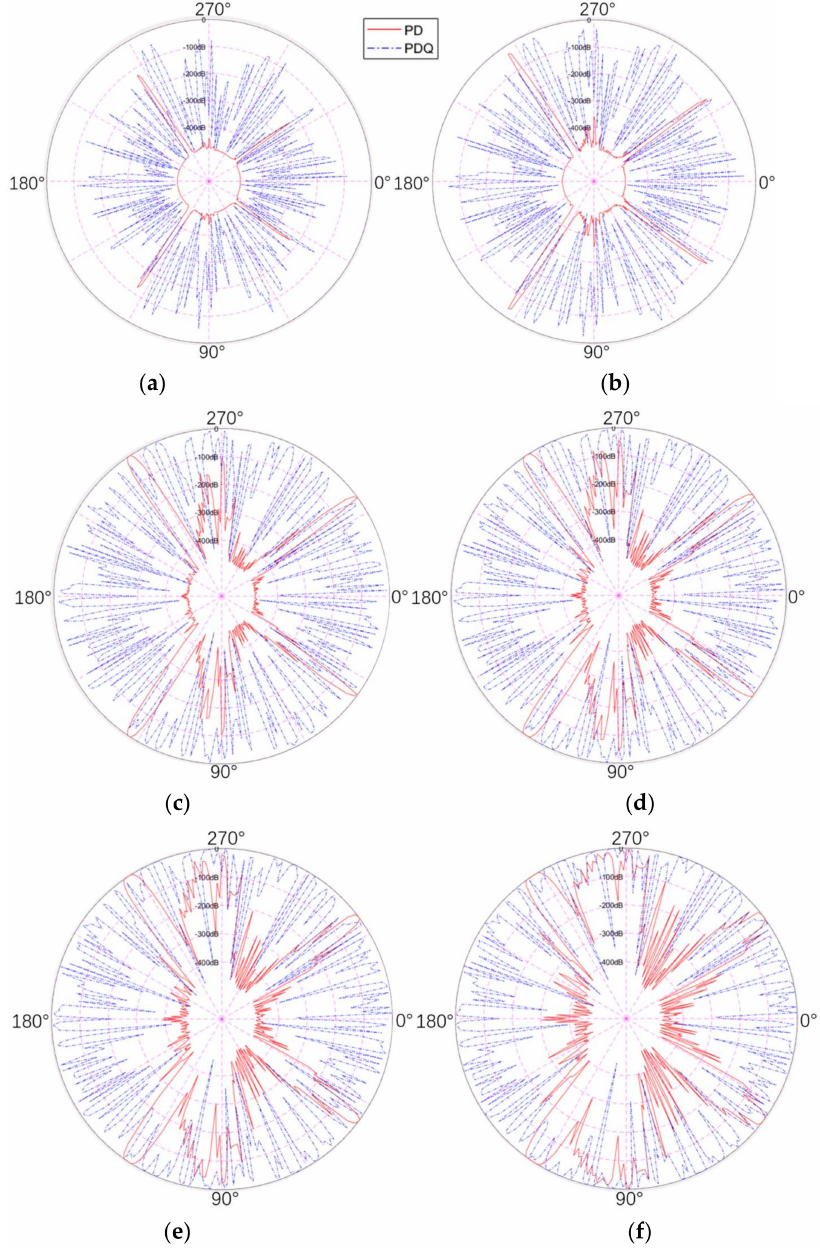
Figure 18. Comparison of detection probability between the quantum radar and the conventional radar at different aperture areas (PD in red lines and PDQ in blue lines). ( a ) 1.4 m 2 , ( b ) 2.6 m 2 , ( c ) 7.3 m 2 , ( d ) 10.5 m 2 , ( e ) 13.9 m 2 , ( f ) 21.5 m 2